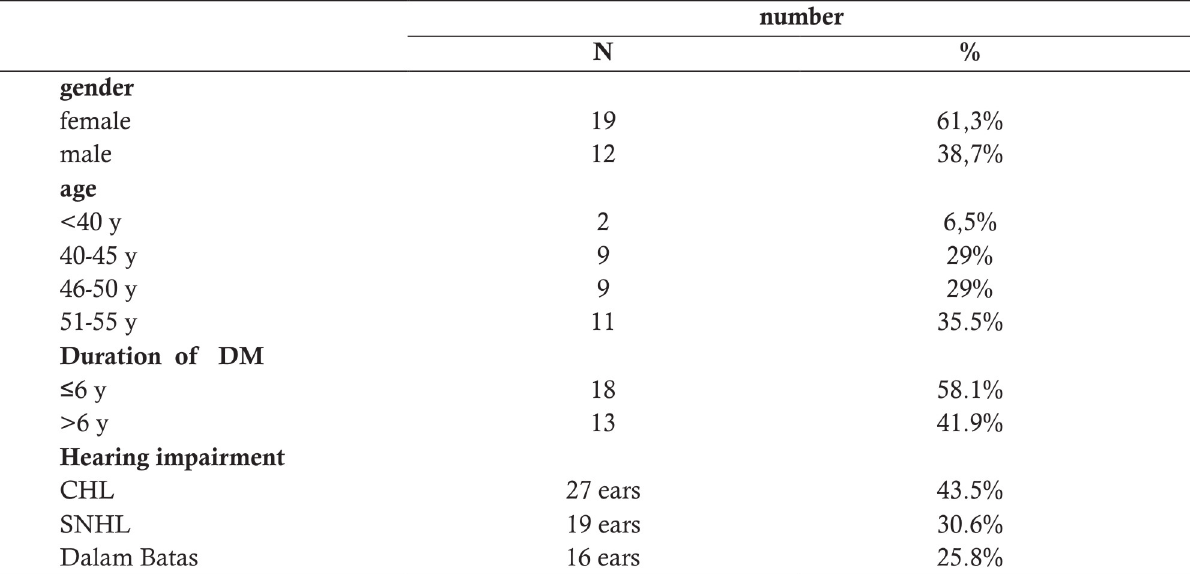
Table . The characteristics of the samples based on gender, age, duration of DM and hearing